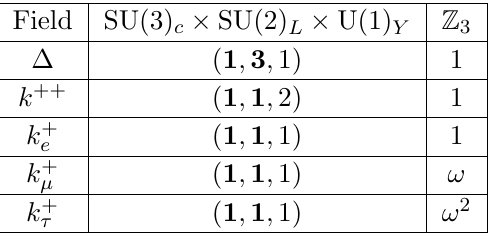
Table 1 . Quantum numbers of the relevant SM (cid:12)elds under the SM gauge group and Z 3 . Here ! = 3 p 1. (cid:0)